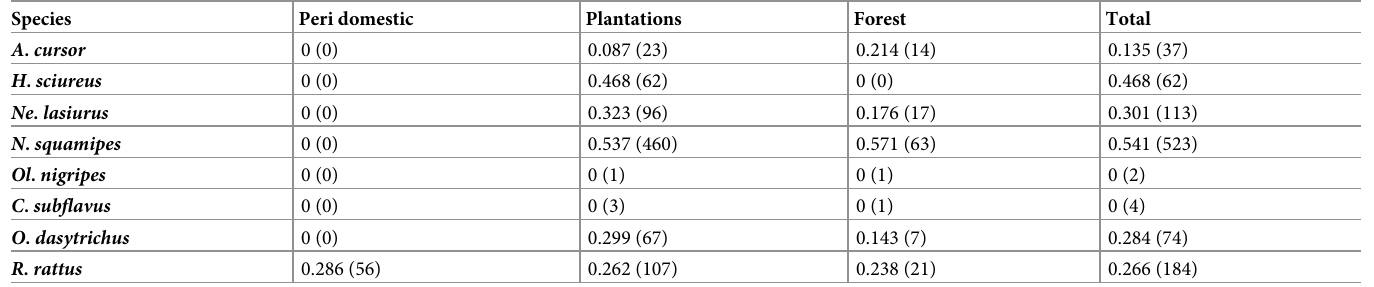
Table 4. Number (n) and proportion of (re)capture events classified as infected 1 by rodent species and ecotype. Species Peri domestic Plantations